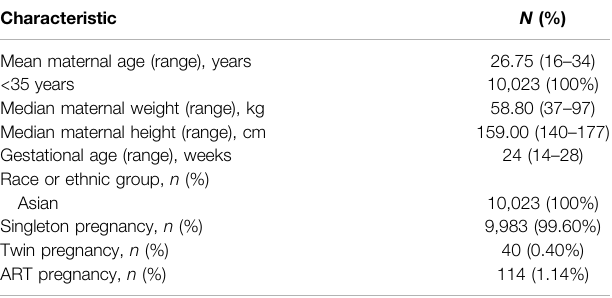
TABLE 1 | Demographic characteristics of the 10,023 patients. Characteristic